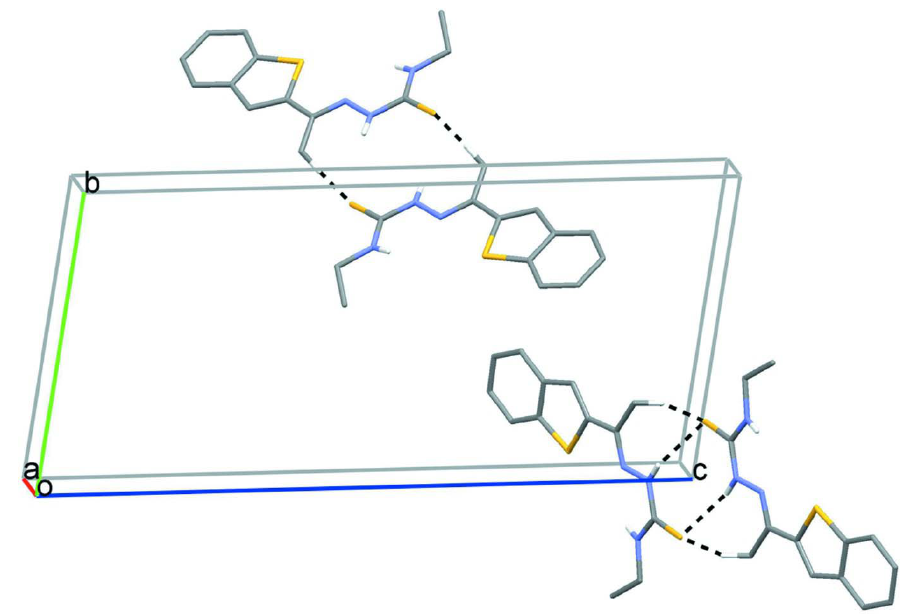
Figure 2 Formation of dimers in the crystal structure of the title compound, through N—H···S and C—H···S hydrogen bonds, shown as dashed lines. H atoms not involved in hydrogen bonding and atoms of one of the disorder components have been omitted for